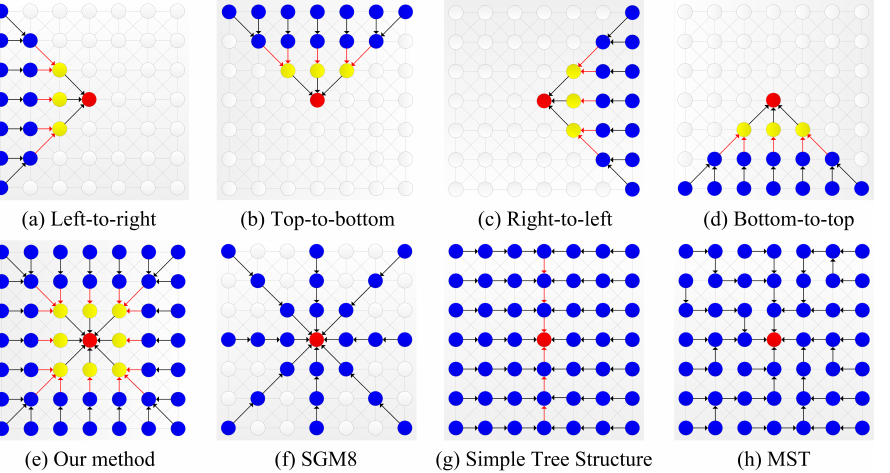
Figure 3. Message propagation strategies in SGM variants. ( a – d ) show the ways to compute aggre- gated costs of root node along each tree in our method. The output of root node in each direction can be computed directly from the outputs of its children nodes (red lines). ( e ) Pixels contributing the output of root node in our method. ( d ) Pixels contributing to the output of root node in SGM along eight directions [22]. ( e ) The means of pixels contributing to the output of root node in simple complementary trees, red line indicates aggregating the output of the first pass [33]. ( d ) Dynamic programming on a minimum spanning tree